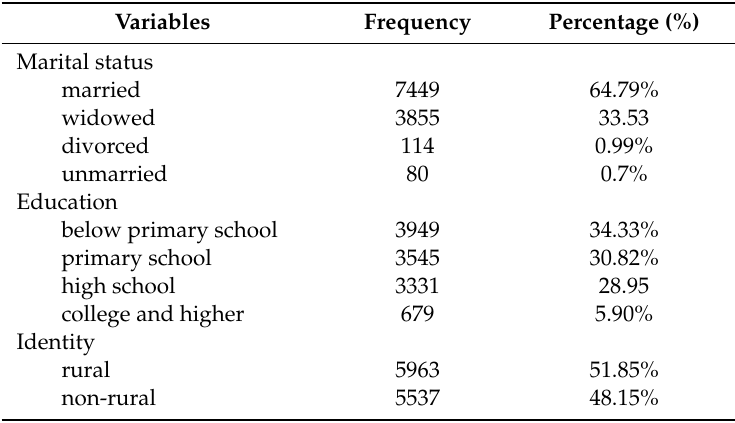
Table 2. Indicators of the latent variables and their measurement questions.